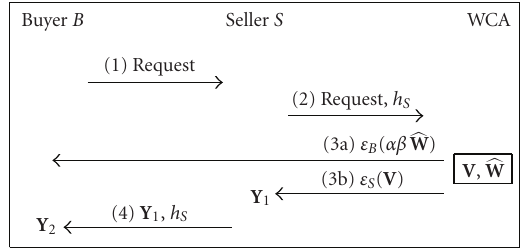
Figure 1: Our proposed watermarking protocol. Y 1 is the seller’s copy, and Y 2 is the buyer’s copy. E B ( · ) is a hybrid encryption [23] with the public key of buyer. h S is the fingerprint of the original image, and it is signed by the seller (the signature is not shown